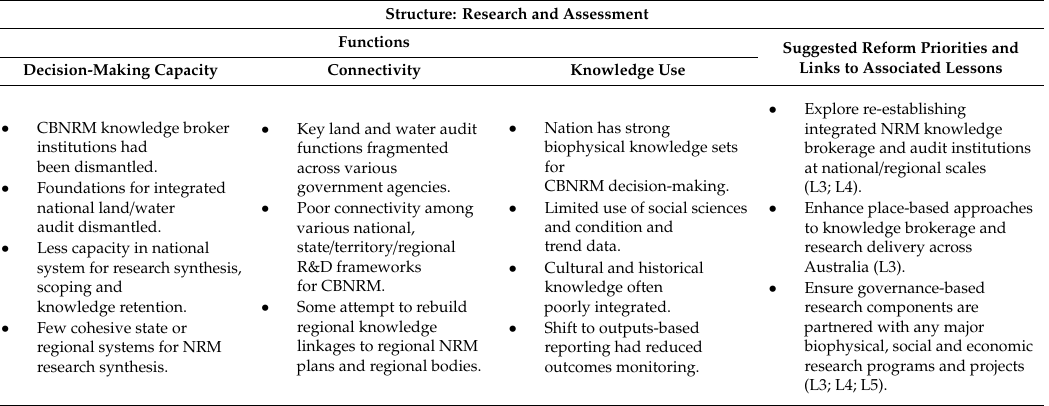
Table 3. A synthesis of findings regarding national aspects of research and analysis in Australia’s CBNRM governance system.